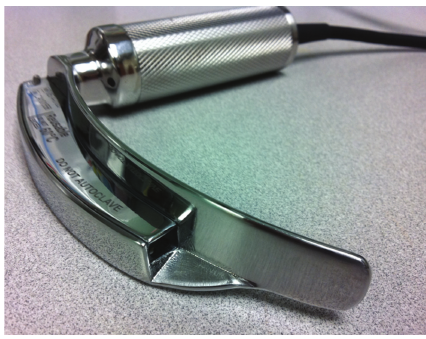
Figure 1: GlideScope Direct video laryngoscope. The video camera and light source are embedded where a light bulb is located on a traditional Macintosh laryngoscope.